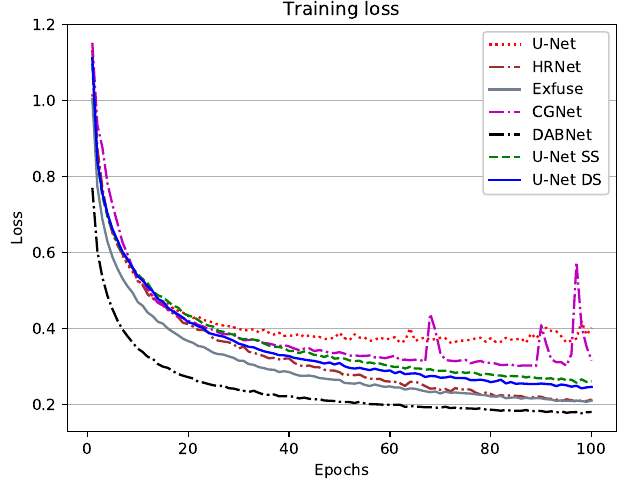
Figure 9. Comparison of the Loss function of the architectures during 100